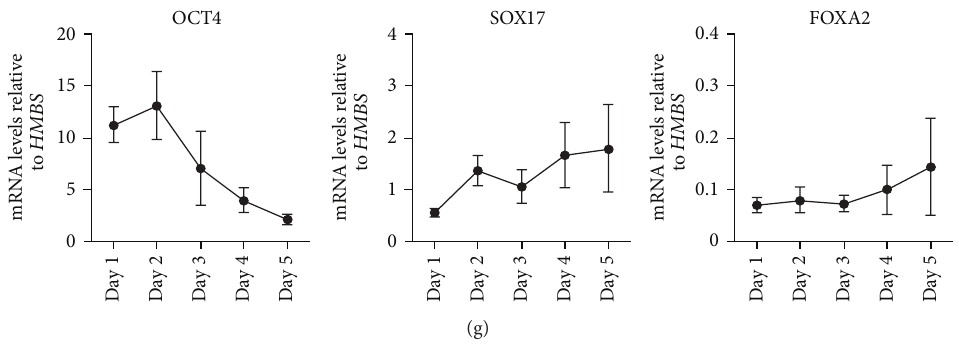
Figure 2: Differentiation of hiPSCs into DE (definitive endoderm) cells. (a) Scheme of monolayer differentiation of hiPSCs into DE cells. (b) Immunocytochemistry shows that hiPSCs-derived DE cells express the early endodermal markers SOX 17 ( red ) or FOXA2 ( green ). Scale bars as indicated. (c) FACS analysis reveals that after 3 days of differentiation approximately 45% of the cells have become SOX17 positive. After 6 days of differentiation about 80% of the cells express SOX17. This data was consistent within two different hiPSC lines. (d) (e) Number of CXCR4/cKIT double-positive cells after 3 days and 5 days of differentiation, respectively. After 5 to 6 days of differentiation both hiPSCs lines express the highest amount of CXCR4/cKIT double-positive cells in the region of 75–80%. (f) Virus-containing hiPSCs (hiPSC 1/hiPSC 2) did not show differences in the number of CXCR4/cKIT double-positive cells compared to virus-free iPSCs (hiPSC Cre). (g) Continuous loss of OCT4 mRNA levels during DE differentiation. In contrast, transcript levels of early endodermal genes such as SOX17 and FOXA2 steadily increased and reached highest levels after 5 days of differentiation. Expression levels are shown relative to the housekeeping gene HMBS ( 𝑛 = 4 , two different hiPSCs